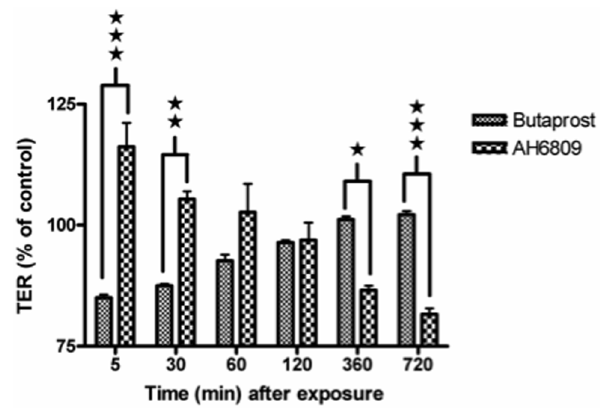
Figure 2. Effect of EP2 receptor agonist and antagonist on TER of Caco-2 epithelial monolayer. Caco-2 monolayer that reached confluence on transwell plate was exposed with either 10 m M of Butaprost (EP2 specific agonist) or 50 m M of AH6809 (EP2 antagonist) on the apical side and TER ( V /cm 2 ) measured at the time indicated for each group, compared to control and depicted as % of control. The mean baseline TER at the start of the experiment was 1025.5 6 71.5 V / cm 2 . w p , 0.05; ww p , 0.01 and www p , 0.001.